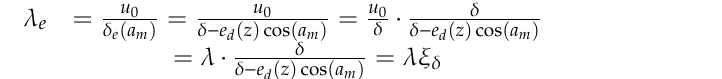
Figure 2. ( a ) Magnet gap deformation of the in-wheel motor (IWM) (air-gap exaggerated) and ( b ) the winding distribution of the permanent magnet brushless direct contact (PMBDC) motor.